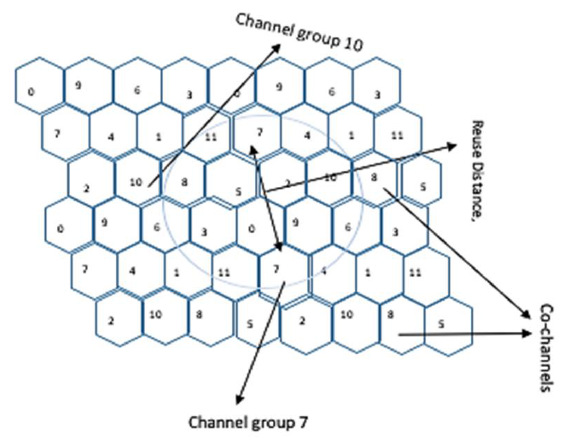
Figure 13. Hypothetical design of a cellular grid labeled with the L(3,1) coloring algorithm.